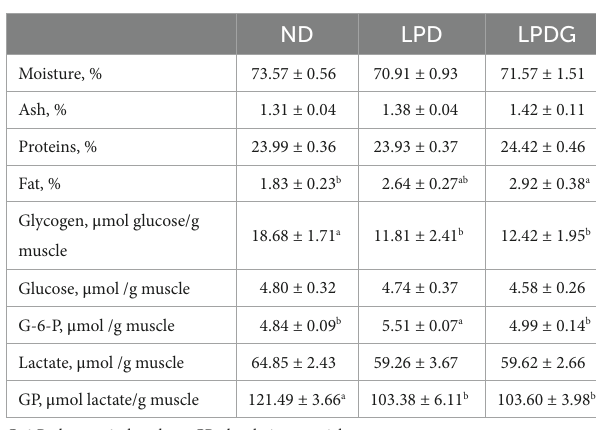
TABLE 1 Chemical composition of LT muscle from growing-finishing pigs receiving a normal, low protein, or low protein supplemented with glycine